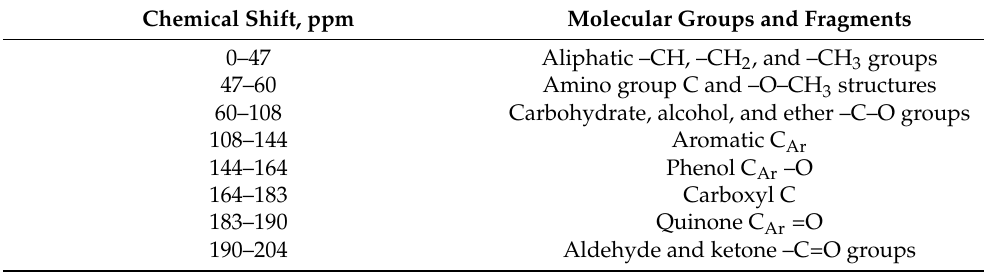
Table 1. 13 CNMR chemical shifts of molecular groups and fragments of humic